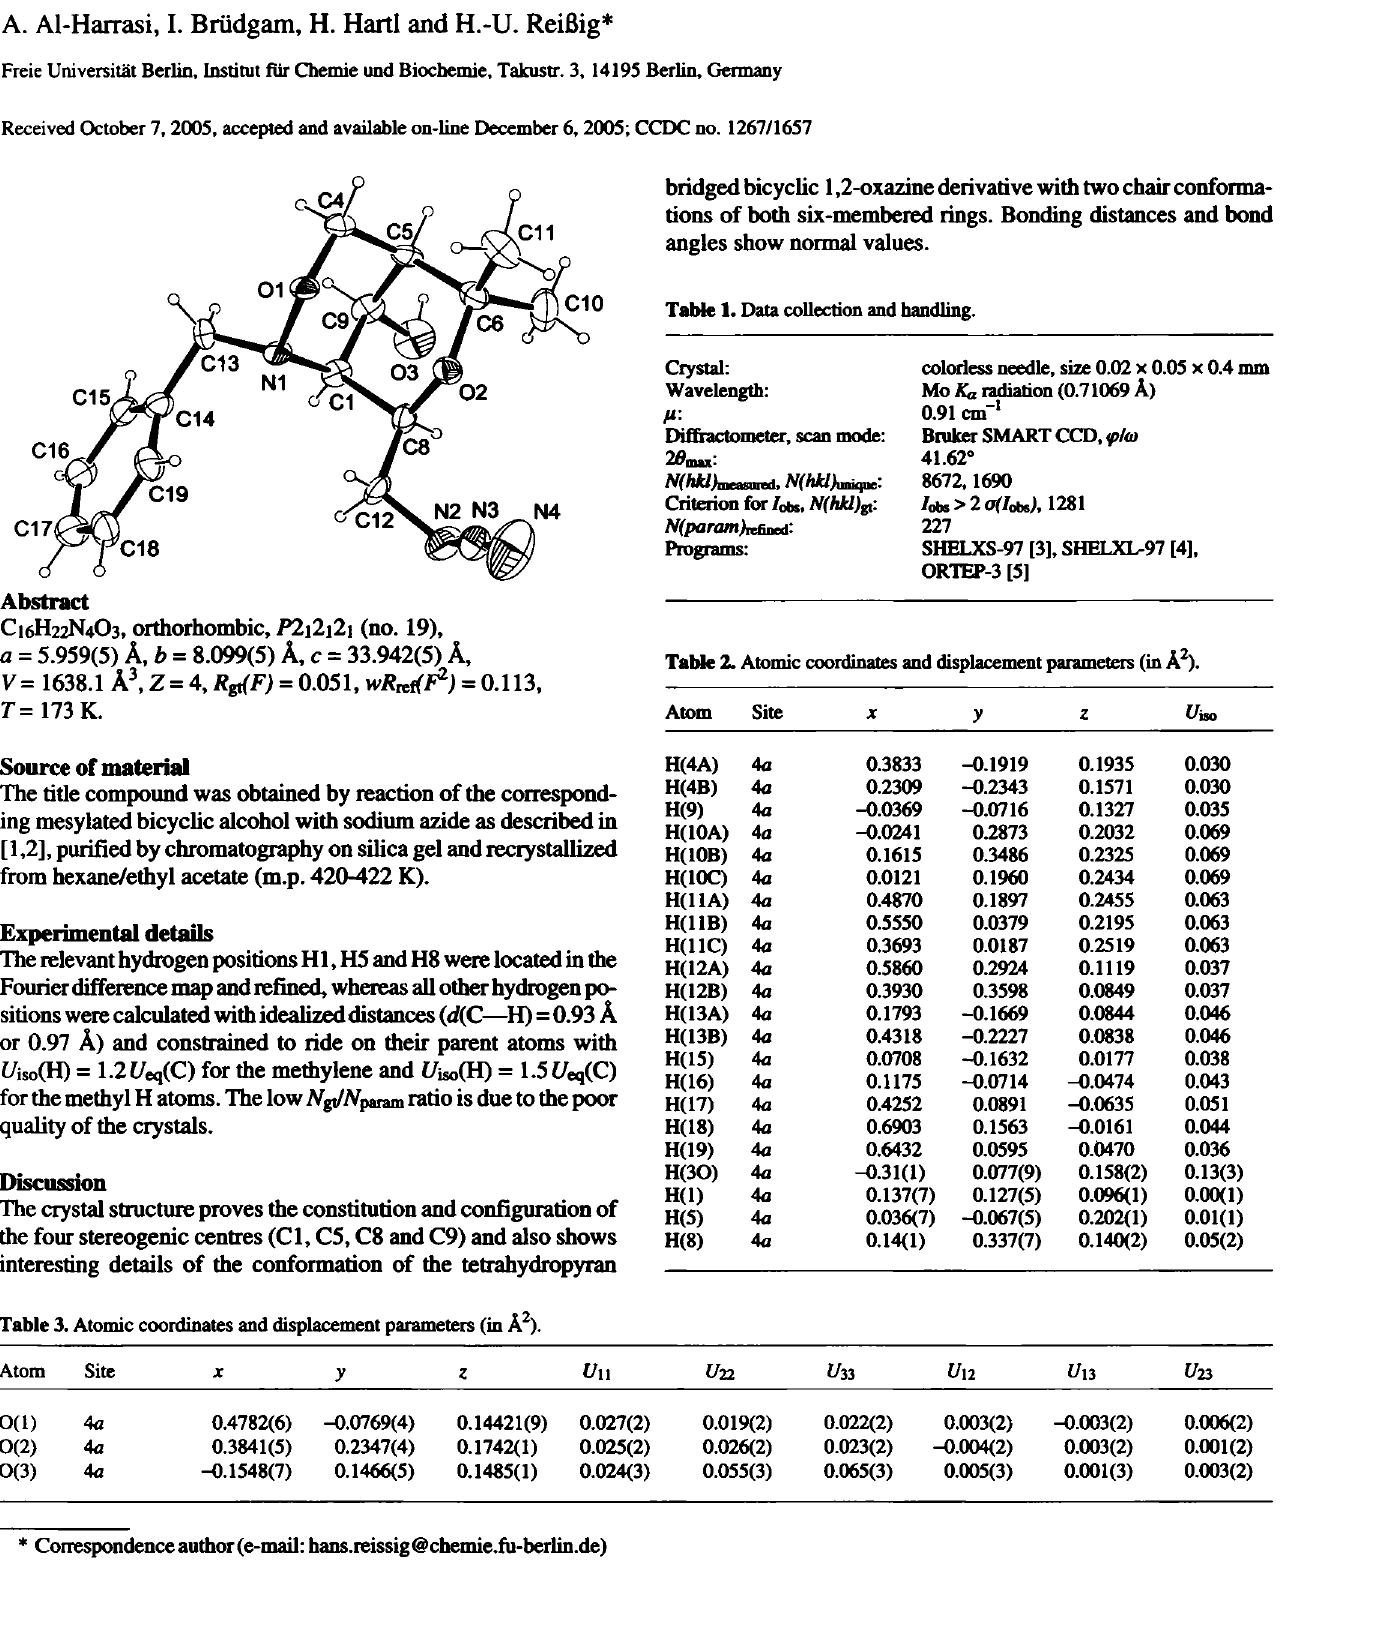
Table 3. Atomic coordinates and displacement parameters (in A 2